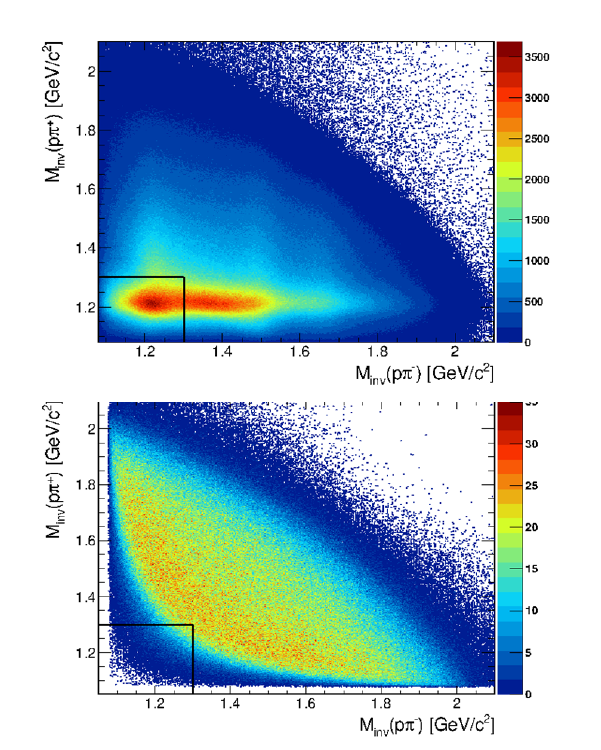
Figure 8. Correlation between p π + invariant mass and p π − in- variant mass for data (top) and for simulation of the pp → pp ρ reaction (bottom). The black lines shows the first rejection ( M in v ( p π + ) < 1 . 3 GeV / c 2 and M in v ( p π − ) < 1.3 GeV / c 2 ) applied to enhance the ρ